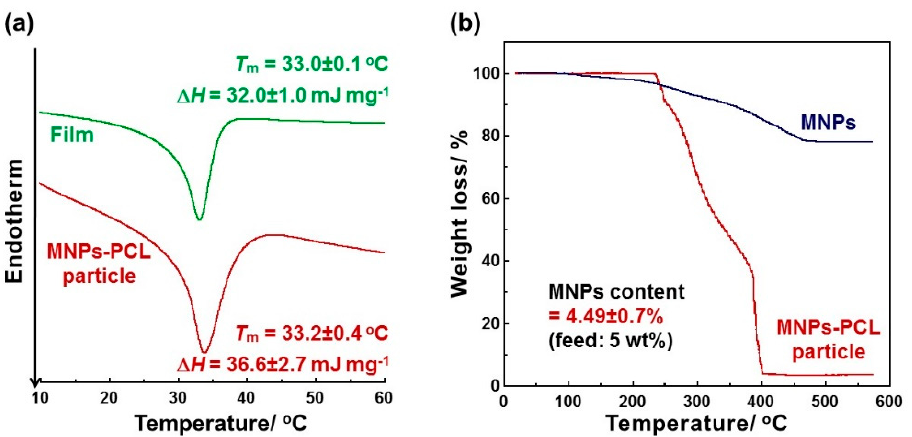
Figure 2. ( a ) DSC curves of shape-memory PCL microparticles containing MNPs and crosslinked PCL film as a control. The T m and ∆ H were estimated from peak top and area of endothermic peak, respectively; ( b ) Thermogravimetric analysis for MNPs as a control and shape-memory PCL microparticles containing MNPs.